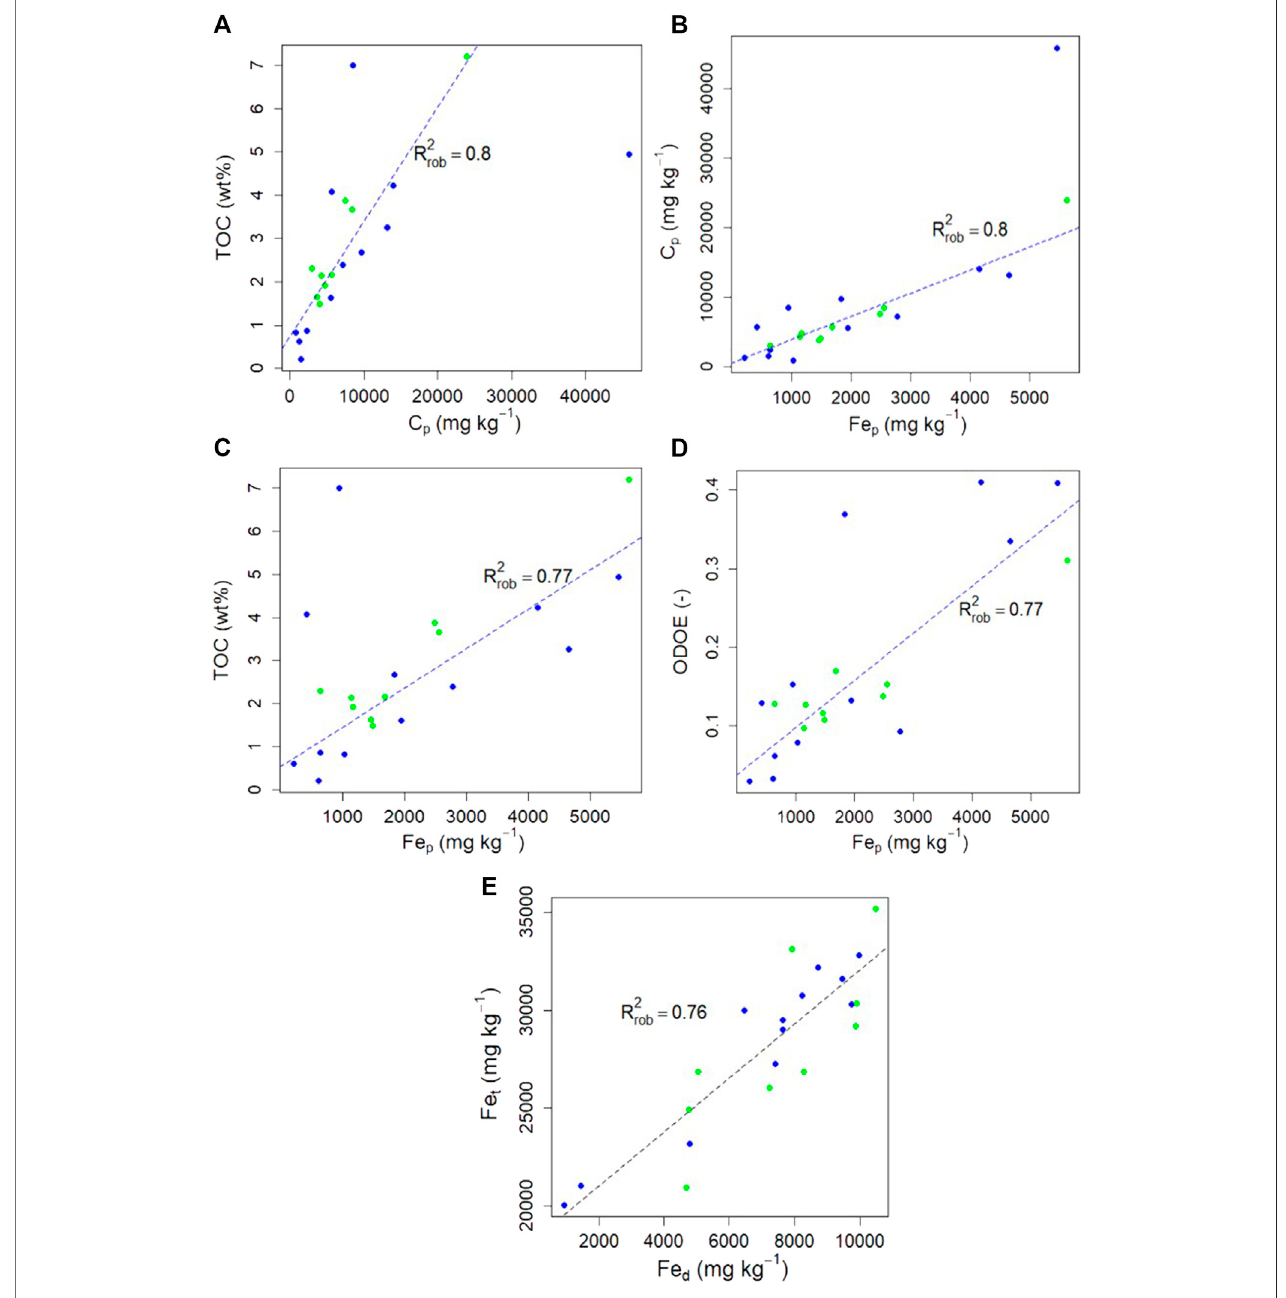
FIGURE 6 | Robust linear regression plots for Yedoma Ice Complex deposits (blue dots) and Alas deposits (green dots) between (A) Total organic carbon (TOC) content (wt%) vs C extracted with pyrophosphate (C p ) (B) C p vs Fe selectively extracted by pyrophosphate (Fe p ) (C) TOC vs Fe p (D) Optical density of oxalate extract (ODOE)vsFe p ;and (E) TotalFeconcentrations(Fe t )vsFeselectivelyextractedbydithionite-citrate-bicarbonate(Fe d ).Dashedlinesrepresenttherobustlinearregression (alpha (cid:1) 0.95; n (cid:1) 21).